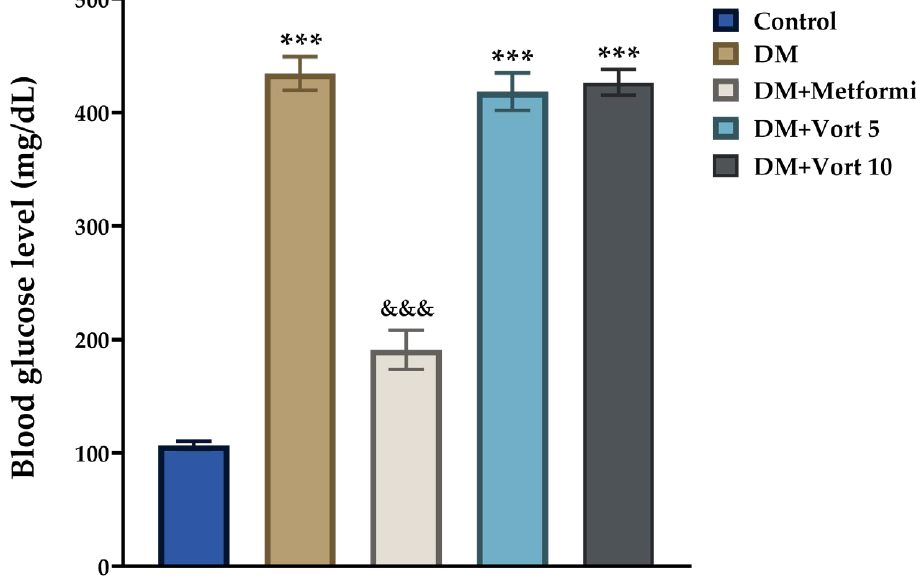
Figure 2. Blood glucose levels in normoglycemic rats administered with saline solution (control) and diabetic rats administered with saline (DM), 1000 mg/kg metformin (DM + Metformin), 5 mg/kg vortioxetine (DM + Vort 5) or 10 mg/kg vortioxetine (DM + Vort 10). Values are given as mean ± S.E.M. Significant difference against control group *** p < 0.001; significant difference against DM group &&& p < 0.001. One-way ANOVA, post hoc Tukey’s HSD multiple comparison test, n =